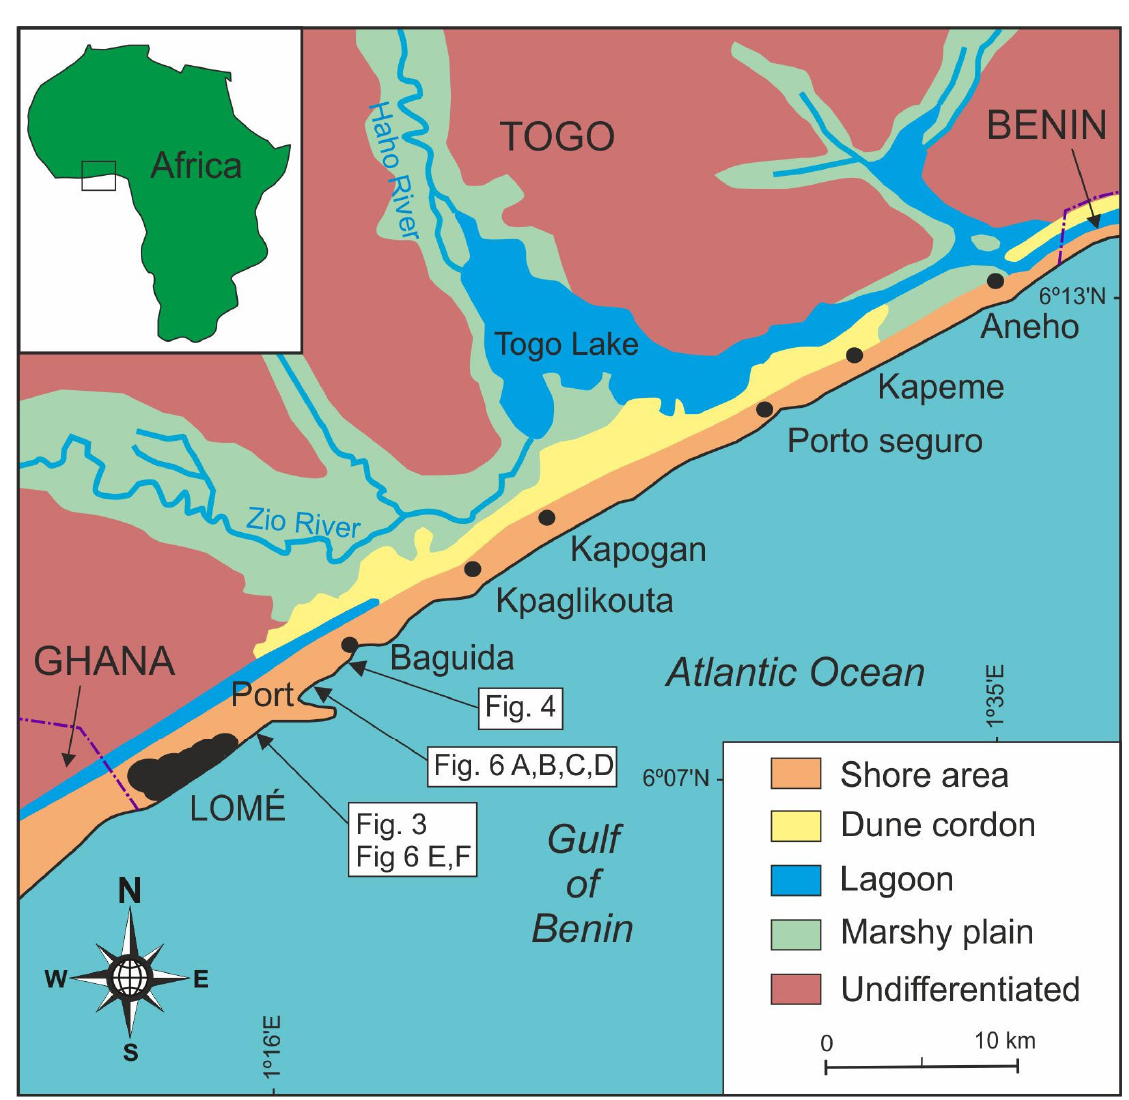
Figure 1. The coast of Togo and neighboring areas (eastern Ghana and western Benin), and some localities mentioned in the text (after [1]), modified).